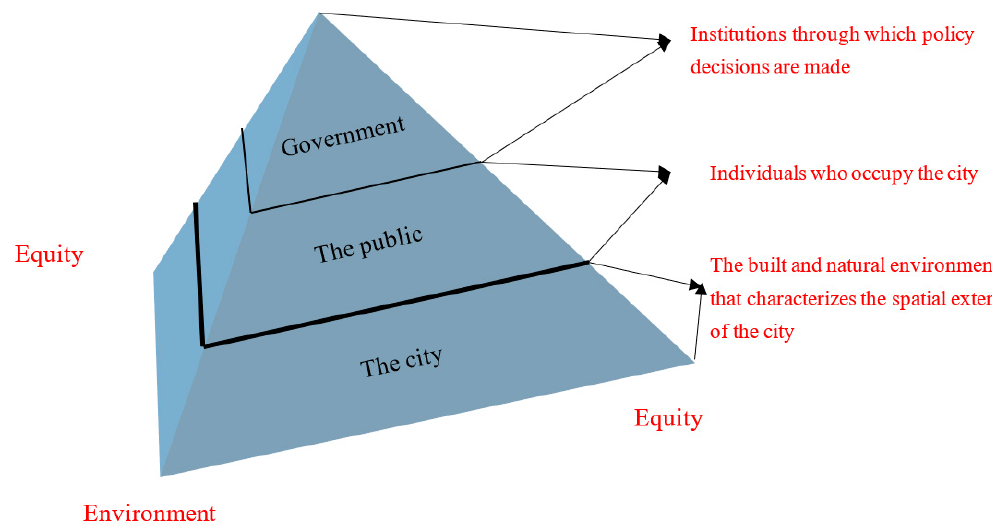
Figure 2. Governing the smart city: Domains of planners and public administrators.